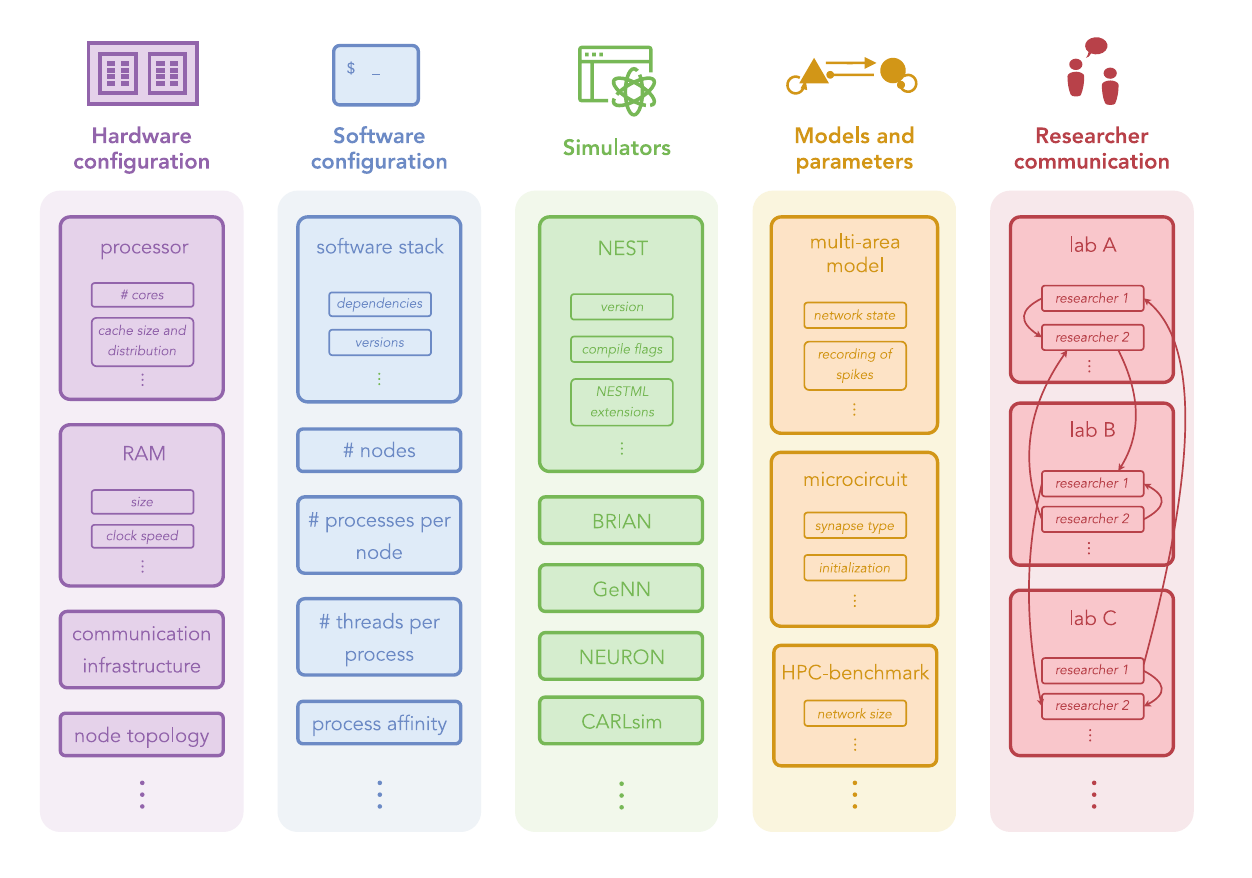
FIGURE 1 | Dimensions of HPC benchmarking experiments with examples from neuronal network simulations. Hardware configuration: computing architectures and machine specifications. Software configuration: general software environments and instructions for using the hardware. Simulators: specific simulation technologies. Models and parameters: different models and their configurations. Researcher communication: knowledge exchange on running